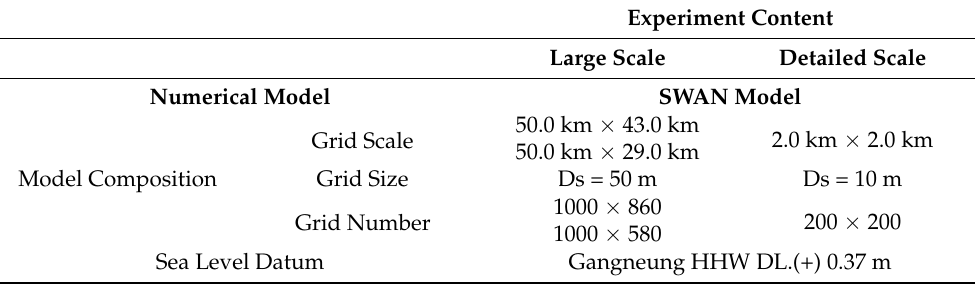
Table 1. An overview of the SWAN model experiment.